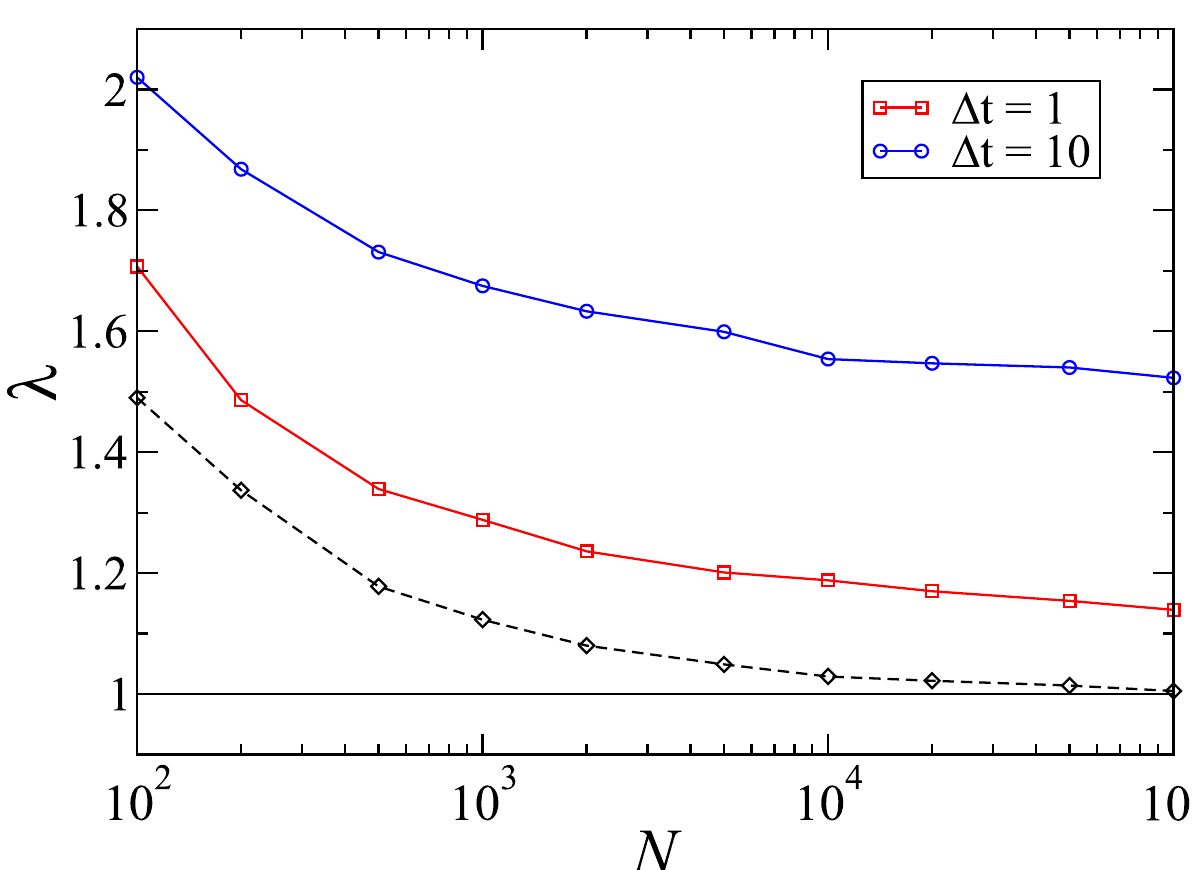
Fig 16. (Color online) CPFS on complete graph with stochastic environment (QS simulations). Pseudocritical point λ c ( N ) (solid curve) and limit of the SS regime λ * ( N )(circles) as function of system size N , for α = 0.1 and σ = 0.8. Dashedlines: limit of the SS regime for the constant environment